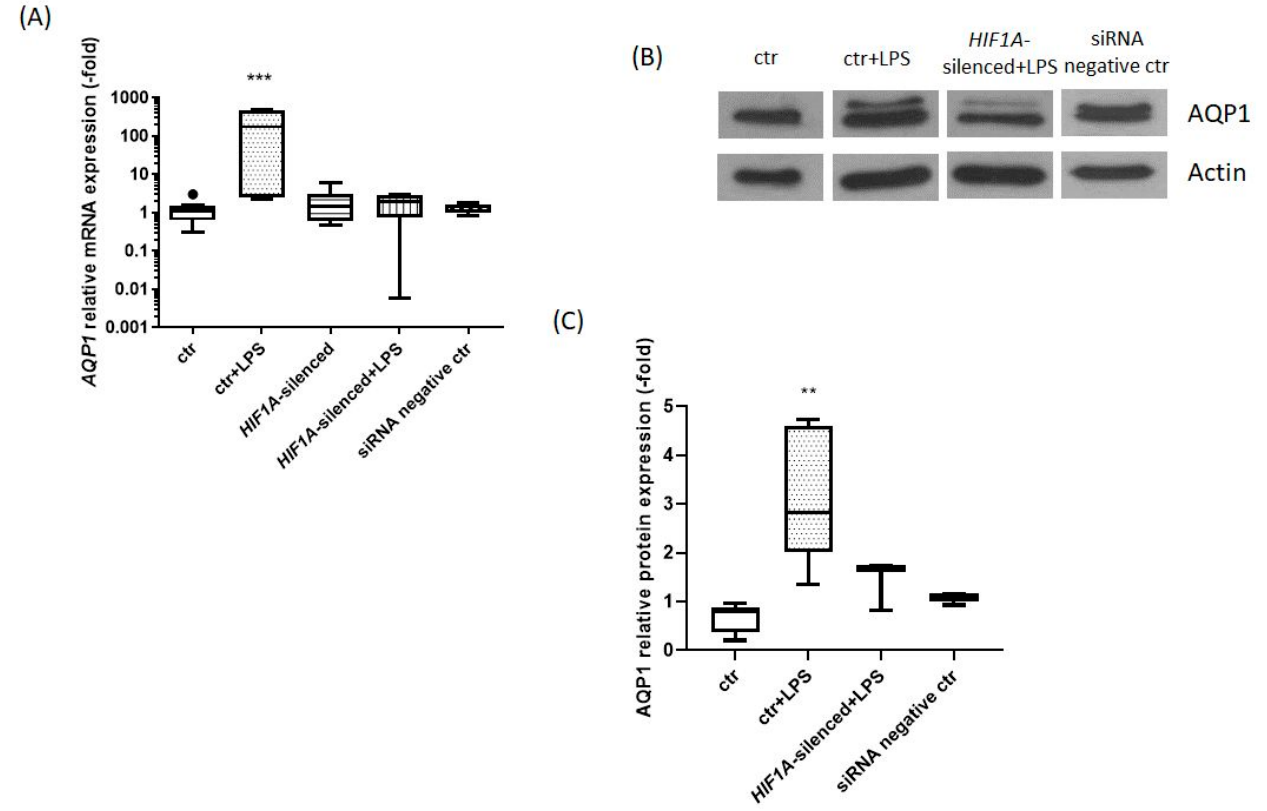
Figure 1. ( A ) AQP1 relative mRNA expression, ( B ) Representative expression of AQP1 and actin proteins in LPS-exposed HPMECs and LPS-exposed HIF1A -silenced HPMECs, ( C ) AQP1 relative protein expression. ( A ) AQP1 mRNA expression was measured in untreated HPMECs (ctr), HIF1A -silenced HPMECs, LPS-exposed HPMECs (ctr + LPS), HIF1A -silenced HPMECs exposed to LPS, and in HPMECs transfected with a universal scrambled negative control siRNA duplex (siRNA negative ctr). Data are presented as box plots. Analysis was performed by one-way ANOVA followed by the Kruskal Wallis posthoc test. Line in the middle, median value; lower and upper lines, 25th and 75th centiles; whiskers, range of values; ***, p < 0.001 compared to ctr. Results from 4 independent experiments. ( B ) Protein expression was analyzed by SDS-PAGE and immunoblotting. Relative protein expression was performed using densitometry with actin as a loading control. ( C ) AQP1 protein expression was measured in untreated HPMECs (ctr), LPS-exposed HPMECs (ctr + LPS), HIF1A -silenced HPMECs exposed to LPS, and in HPMECs transfected with a universal scrambled negative control siRNA duplex (siRNA negative ctr). Data are presented as box plots. Analysis was performed by one-way ANOVA followed by the Kruskal Wallis posthoc test. Line in the middle, median value; lower and upper lines, 25th and 75th centiles; whiskers, range of values; **, p < 0.01 compared to ctr. Results from 3 independent experiments.